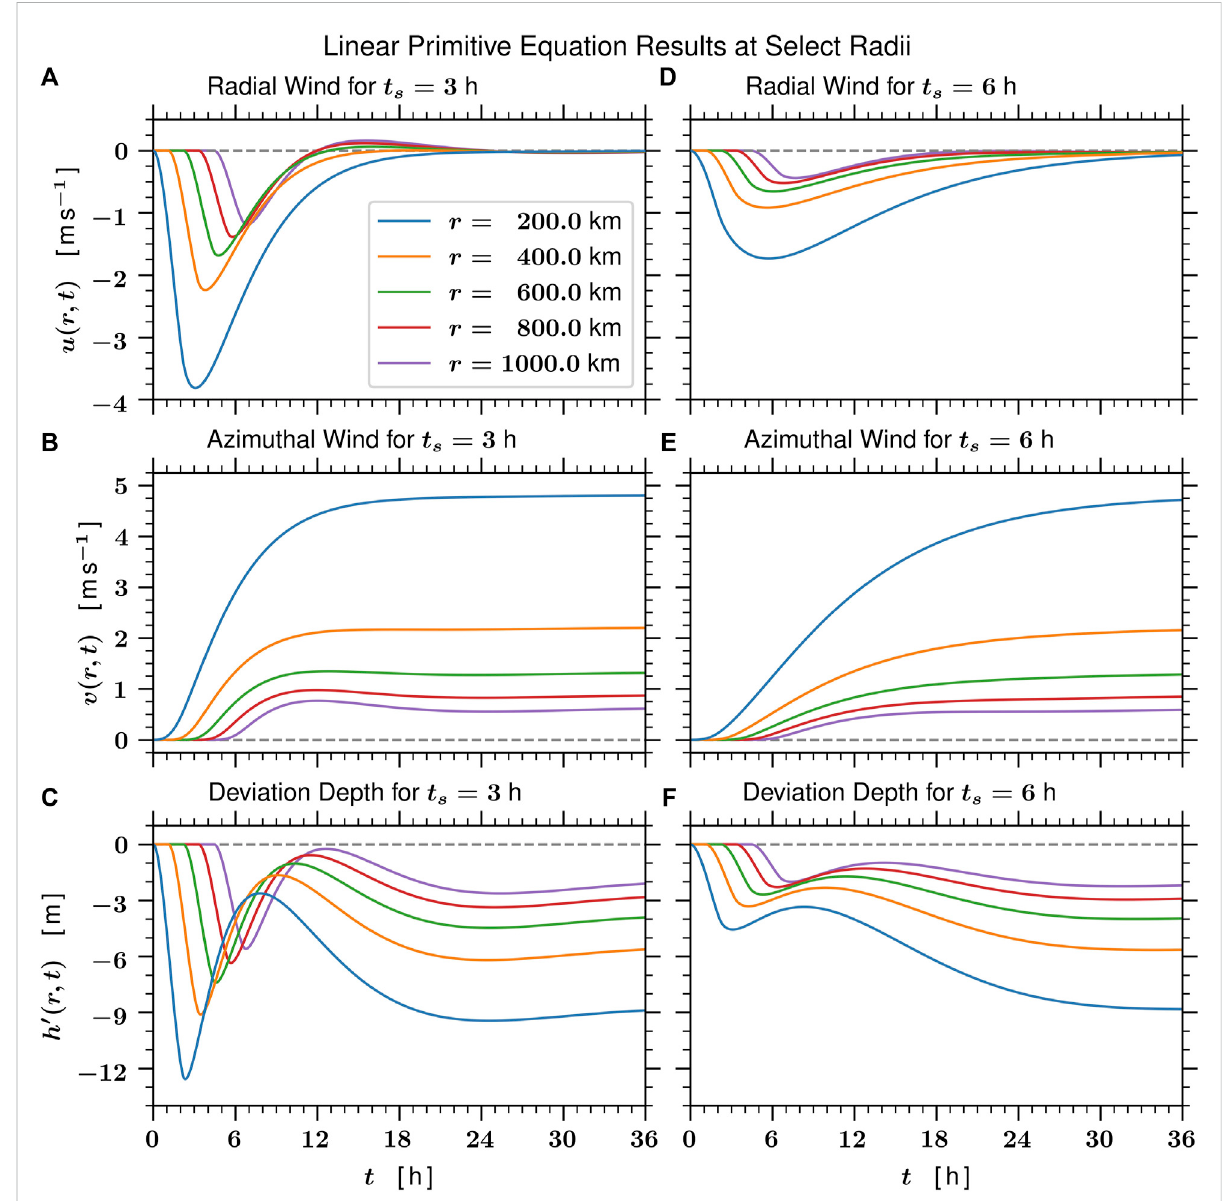
FIGURE 4 This fi gure shows the time dependence of the linear primitive equation solutions for the radial fl ow u ( r , t ), the azimuthal fl ow v ( r , t ), and the deviation depth h ′ ( r , t ) at the selected radii r =200,400,600,800,1000 km for the rapid forcing case t s =3 h (A-C) and for the less rapid forcing case t s =6 h (D-F) .NotethatthesecurvesaresimplyverticalcrosssectionsfromFigures2,3.Theoutwardpropagatinginertia-gravitywavepacketismost readily apparent in the h ′ ( r , t )- fi eld, where it is immediately seen at r =200 km, and is seen, for example, with an approximately 4.5 h delay at r =1000 km. At each radius for the rapid forcing case ( t s =3 h) these linear primitive equation solutions for h ′ ( r , t ) overshoot before coming into adjustment at a value that equals h b ′ ( r , ∞) . The less rapid forcing case ( t s =6 h) generates a weaker inertia-gravity wave packet that does not result in such an overshoot in the h ′ ( r , t )